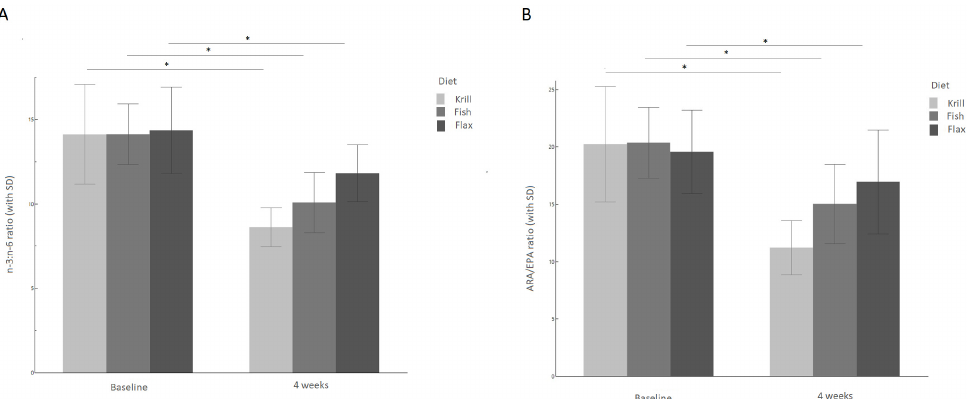
Figure 2. n-6/n-3 and ARA/EPA ratios (with SD). ( A ) n-6 to n-3 ratio (with SD) for the krill, fish and flax groups after four weeks of feeding ( n = 45). ( B ) ARA/EPA ratio (with SD) for the krill, fish and flax groups after four weeks of feeding ( n = 45). Asterisk indicates significant difference between baseline and end of study for the treatment group. The comparison test is carried out using the Wilcoxon matched-pairs signed rank test. Abbreviations: ARA: arachidonic acid, EPA: eicosapentaenoic acid.